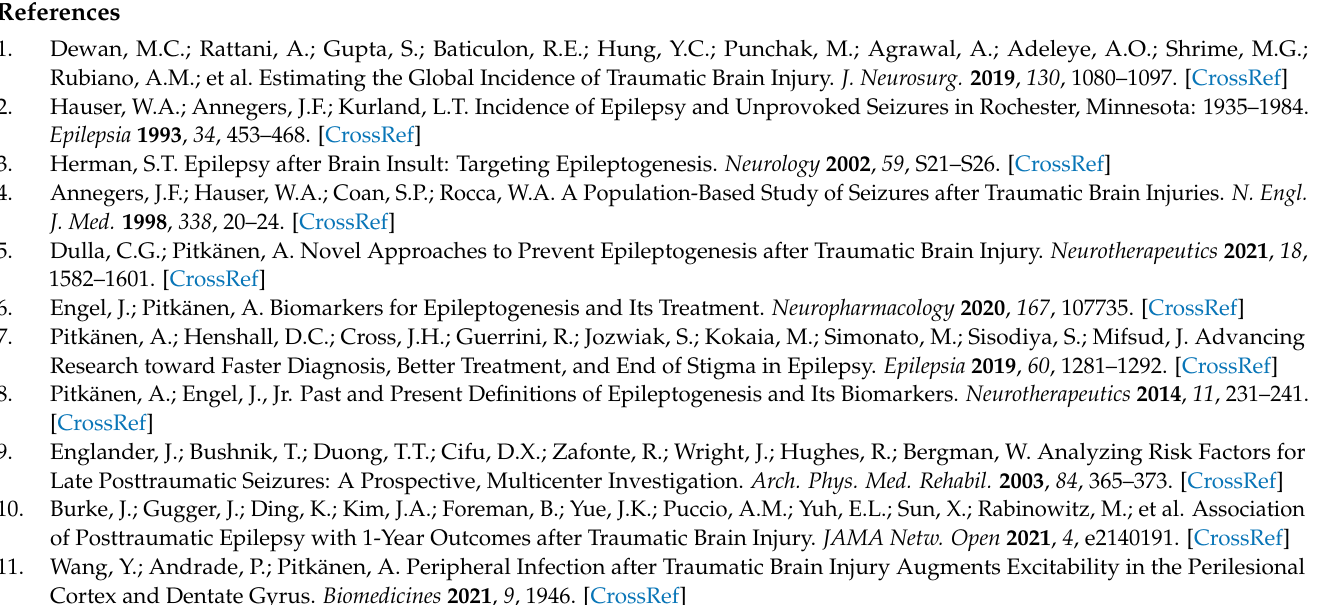
epileptiform activity. Table S2: Seizure susceptibility in the PTZ test on day (D) 30, D60, D90, and D180 after lateral fluid-percussion -induced TBI in rats with (TBI+) or without (TBI − ) epilepsy. Table S3: Duration of different sleep–wake stages in rats with (TBIe+) or without any epileptiform activity (TBIe − ) after traumatic brain injury (TBI) during the lights-on and lights-off periods. Table S4: Number of transitions and fragmentation index in rats with (TBIe+) or without any epileptiform activity (TBIe − ) after traumatic brain injury (TBI) during the lights-on and lights-off periods. Table S5: Duration of different sleep–wake stages in rats with (TBI+) or without epilepsy (TBI − ) after traumatic brain injury (TBI) during the lights-on and lights-off periods. Table S6: Number of transitions and fragmentation index in rats without (TBI − ) or with epilepsy (TBI+) after traumatic brain injury (TBI) during the lights-on and lights-off periods. Table S7: Receiver operating characteristics (ROC) analysis of single pentylenetetrazol (PTZ)-test parameters as biomarkers for TBI and epileptogenesis. Table S8: Receiver operating characteristics (ROC) analysis of single sleep parameters as biomarkers for traumatic brain injury (TBI) and epileptogenesis. Table S9: Summary of studies assessing seizure susceptibility at different time points after lateral fluid-percussion -induced traumatic brain injury in